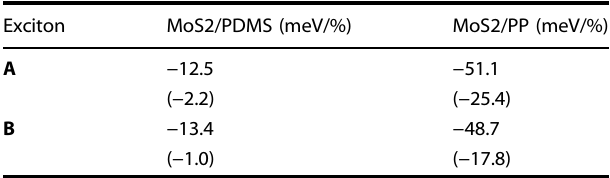
Table 1. Experimental gauge factors of single-layer MoS 2